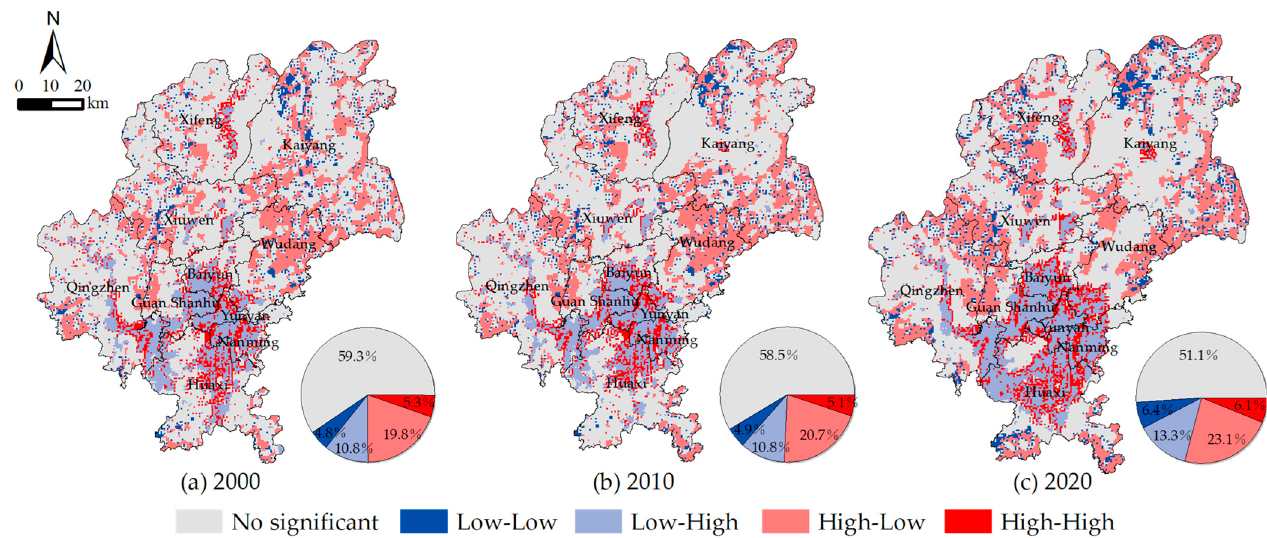
Figure 9. Spatio-temporal relationships between habitat quality and human footprint in Guiyang city Figure 9. Spatio ‐ temporal relationships between habitat quality and human footprint in Guiyang from 2000 to city from 2000 to 2020.